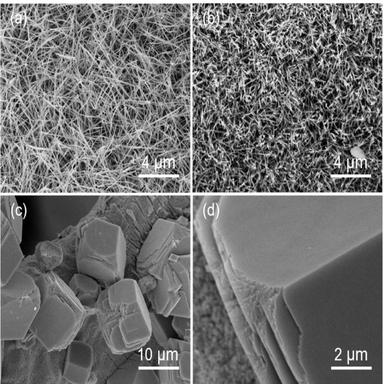
The N2 adsorption-desorption isotherm curves of (a) MCO-NWs and (c) MCO-MCs, and the plots of pore size for (b) MCO-NWs and (d) MCO-MCs.